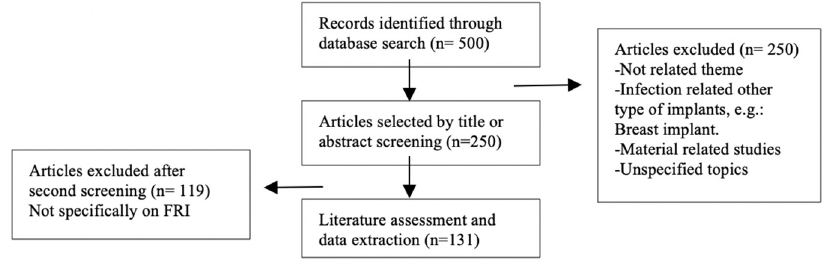
Figure 1. Flowchart of the identification of relevant articles.